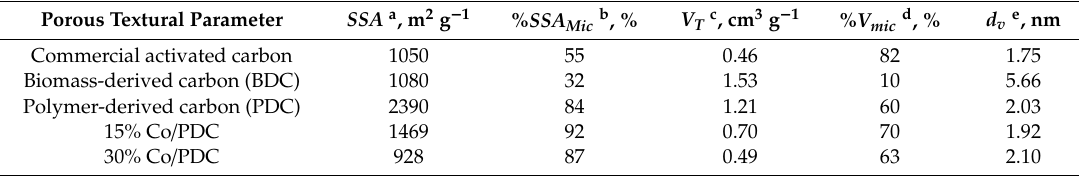
Table 1. Pore parameters calculated from N 2 -adsorption desorption isotherm.